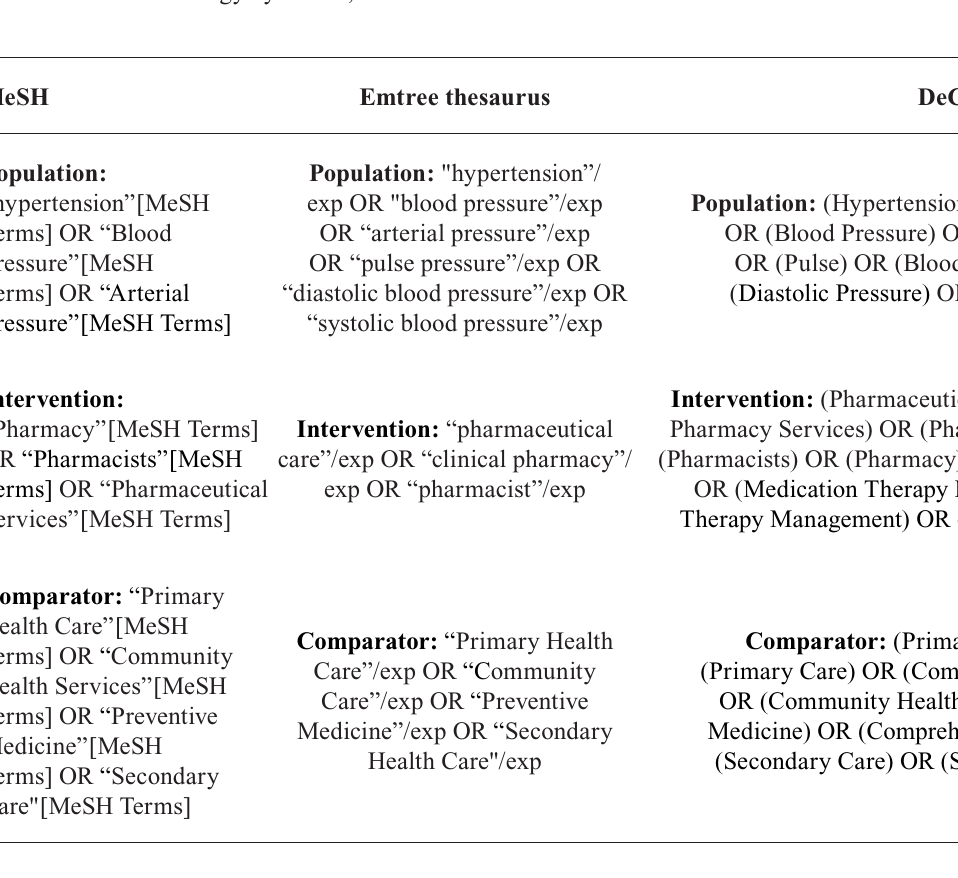
TABLE II - Search strategy by MeSH, Emtree thesaurus and DeCS linked database